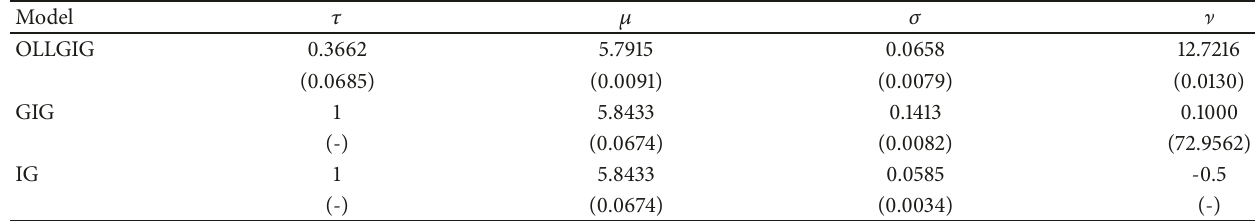
Table 4: MLEs and SEs (in parentheses) of the model parameters for the iris data.